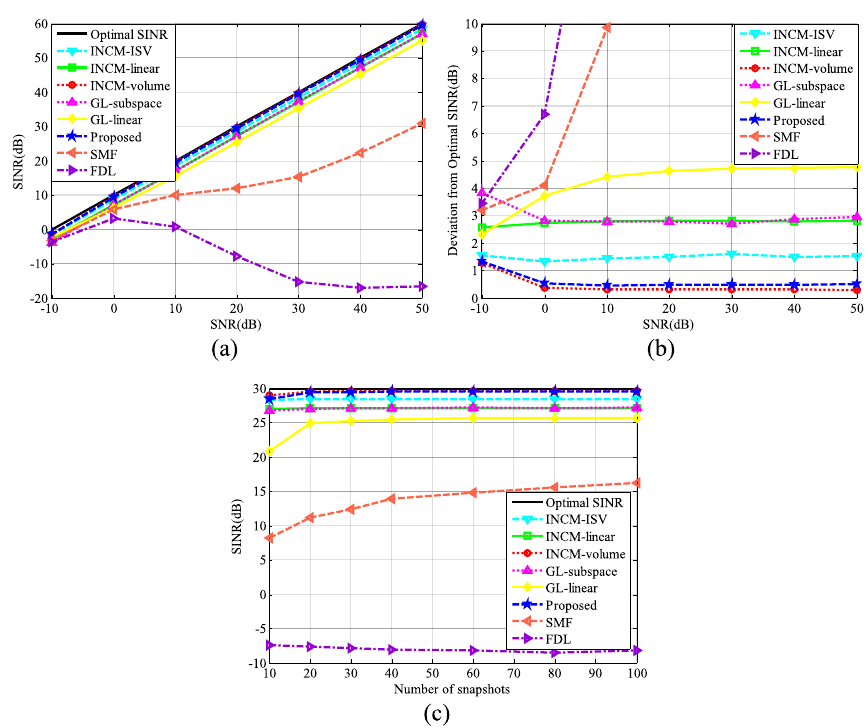
Fig. 5 Performance comparison. a SINR versus SNR. b Deviation against SNR. c SINR against number of